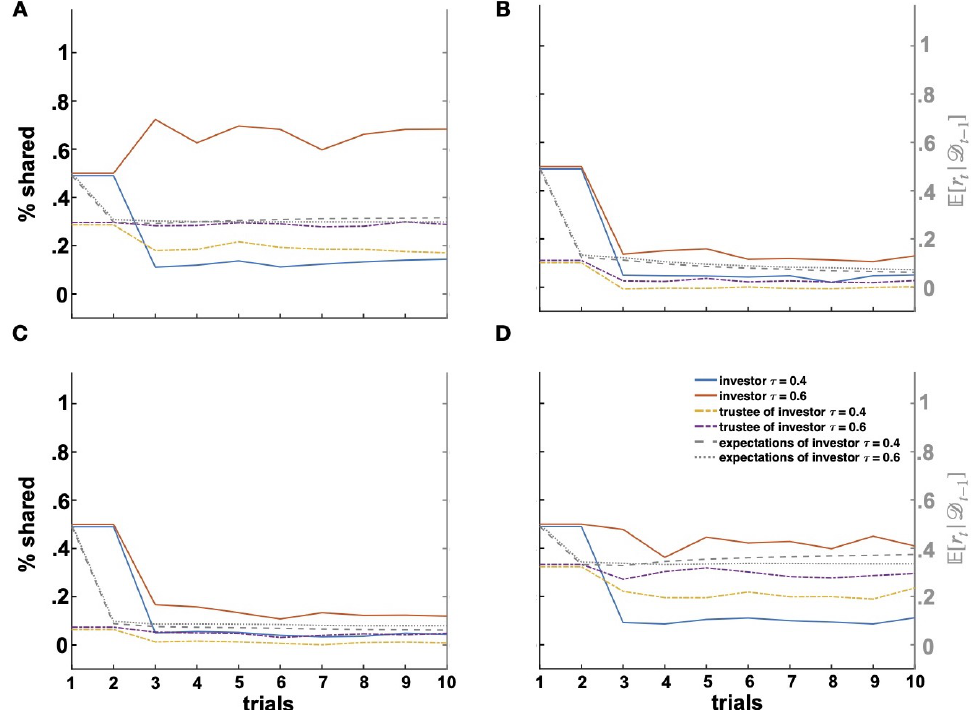
Figure 7. Competence and benevolence. Investments over time (trials) shared by investors interacting with different trustee types, that is: benevolent and competent ( A ); malevolent and incompetent ( B ); malevolent and competent ( C ); and benevolent and incompetent ( D